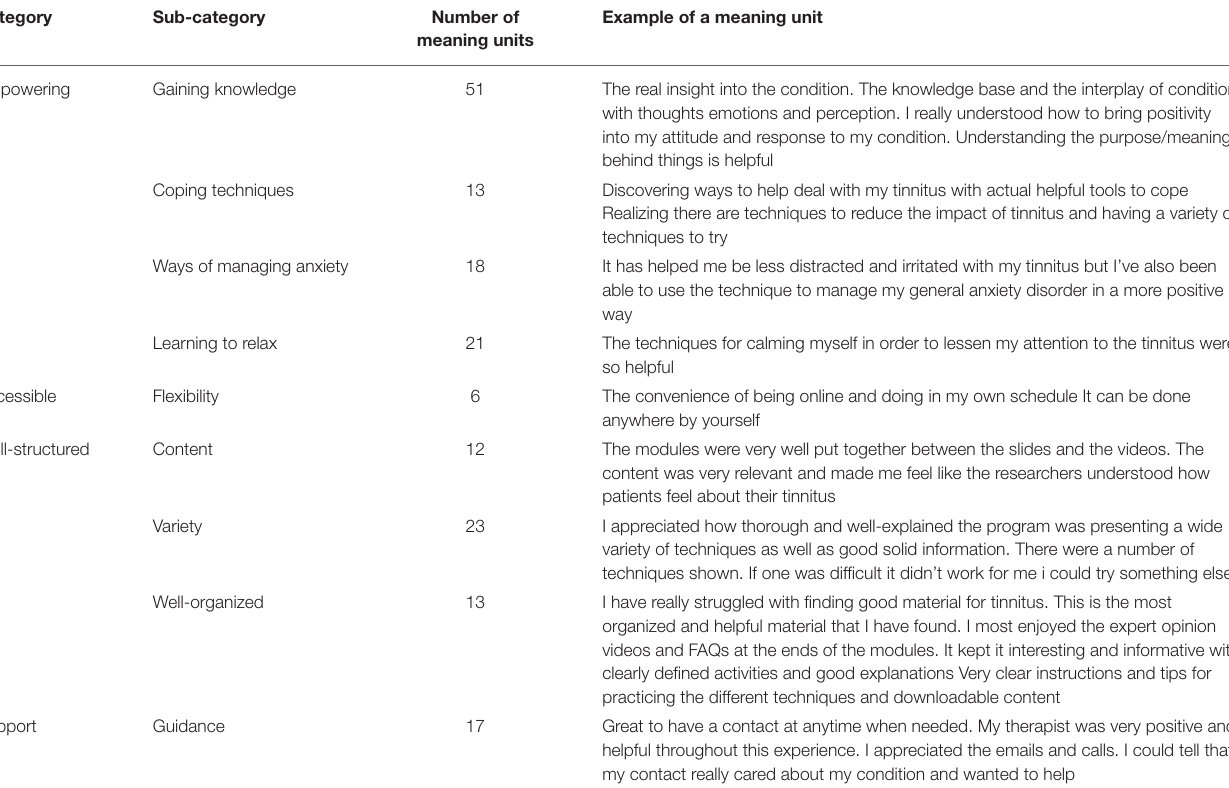
TABLE 7 | The facilitators of effectiveness to the intervention.